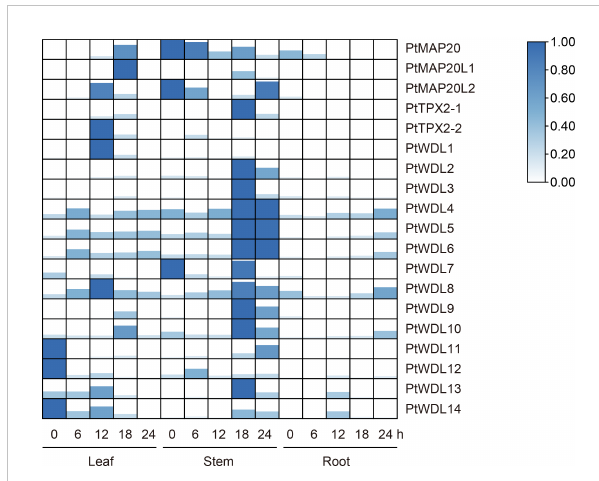
FIGURE 8 Heatmap of PtTPX2 gene expression patterns in different tissues and processing time under salt stress. The graphic size and color represent the level of expression of each gene in each sample. The gene expression levels were calculated based on 2 − DD Ct .